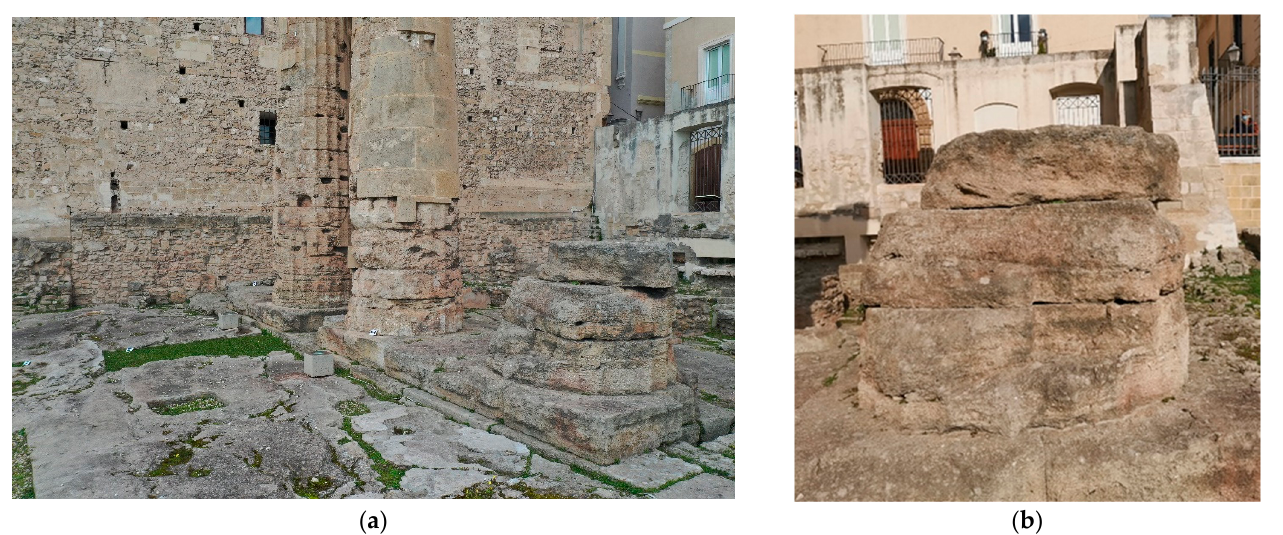
Figure 5. Overview of the Doric columns of Taranto ( a ); remains of the third column used for the fourth test ( b ).